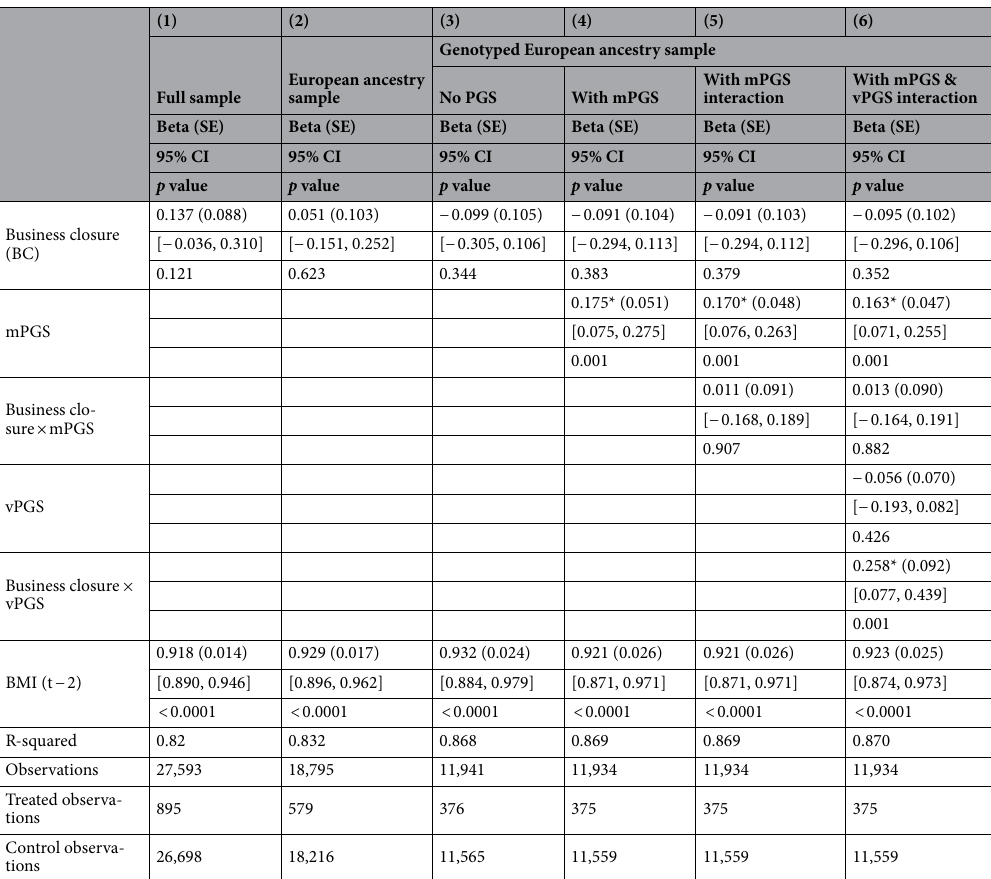
Table 3. Effect of job loss from a business closure on BMI with and without mPGS and vPGS interactions for workers aged 50–70 in the Health and Retirement Study (HRS). *FDR corrected p value < 0.05. Abbreviations: SE, standard error; CI, confidence interval. Robust standard errors in parentheses. Each column in the table shows separate propensity score matched models for workers aged 50–70. All specifications adjust for BMI in the previous wave, or BMI (t − 2), and for the conditioning variables used in the propensity score matching that are reported in Table 1 and defined in detail in Supplementary Table S1. Columns 1–3 do not include mPGS or vPGS in the matching procedure. Column 1 includes all workers, regardless of ancestral background or the availability of genotype data and includes additional controls for race and Hispanic ethnicity in the matching procedure. Column 2 reports results for all European ancestry workers, regardless of the availability of genotype data. Column 3 reports results for the European ancestry sample with genotype data prior to matching on the mPGS and vPGS. Columns 4–5 include the mPGS in the matching procedure, and Column 6 includes the mPGS and the vPGS in the matching procedure. Individuals in the control group can have multiple observations. In the analytic sample, unique N(control) = 3564; unique N(treated) =